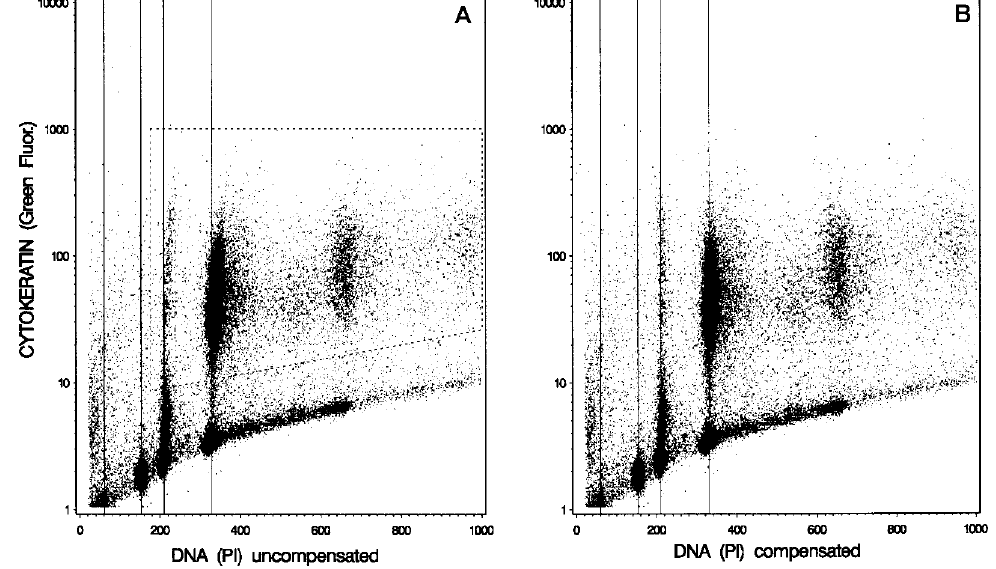
Fig. 1. Dot plot showing gating on cytokeratin stained cells (cytokeratin-positive within the dashed frame) before (A) and after compensation for spectral overlap (B). The compensation was based on regression analysis for the subset of G 1 cells with green fluorescence as the independent variable and red fluorescence as the dependent variable. The vertical lines indicate from left to right the G 1 peak positions of chicken and trout red blood cells, DNA diploid and DNA aneuploid